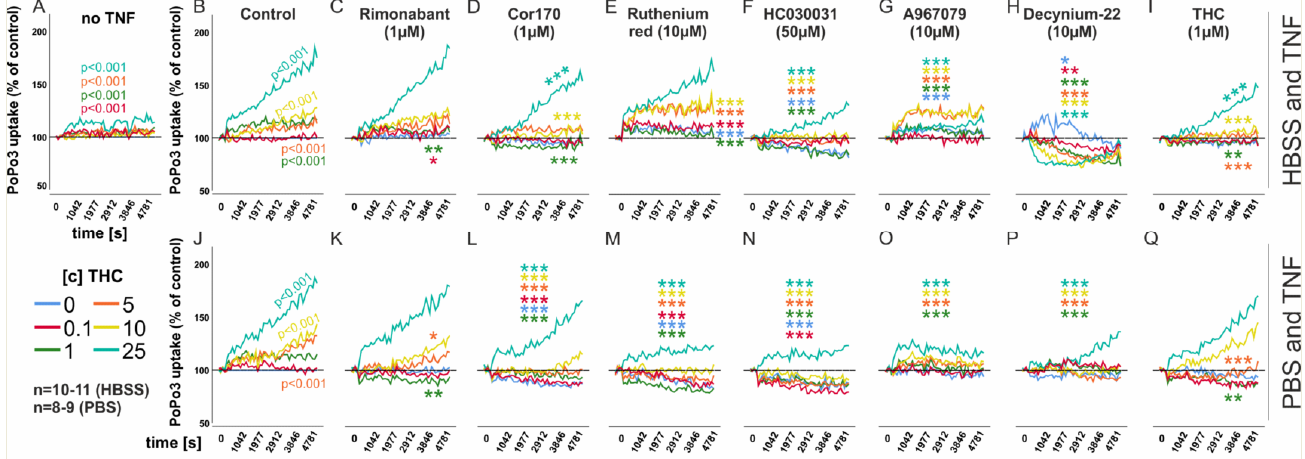
Figure 3. Mean PoPo3 uptake by RASF in response to THC. ( A ) PoPo3 uptake without TNF pre–stimulation, ( B , C ) by THC with TNF (10 ng/mL) pre–stimulation for 72 h and extracellular calcium (HBSS; ( B – I )) or without calcium (PBS; ( J – Q )). *** p < 0.001, ** p < 0.01, * p < 0.05 for differences between antagonist treatment and control (THC only, Figure 2B,J). ( B , J ) Comparisons of different THC concentrations versus control (no THC). Significant values are given in the graph. ANOVA with Bonferroni post hoc test was used for all comparisons. Rimonanbant, CB 1 inverse agonist; COR170, CB 2 inverse agonist; A967079, TRPA1 antagonist; HC-030031, TRPA1 antagonist; RR = Ruthenium Red, general TRP inhibitor, Decynium-22, organic cation transport inhibitor.